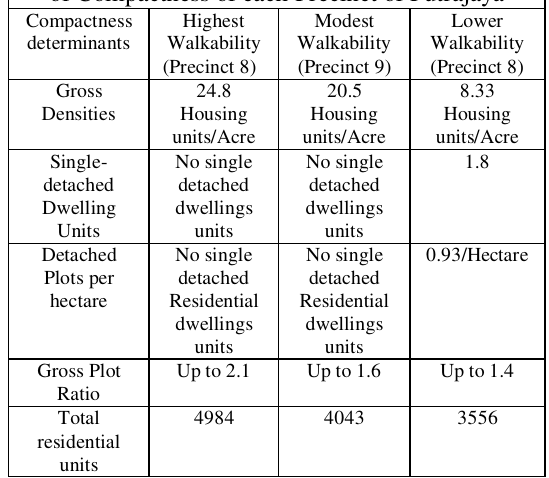
Table 2: Indicators Measured for the Assessment of Compactness of each Precinct of